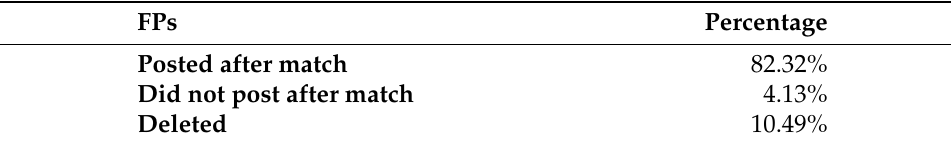
Table 4. User activity distribution among FPs.